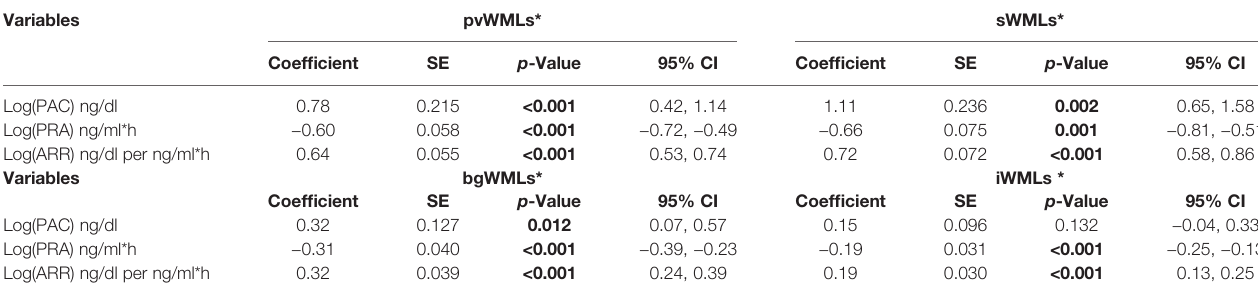
TABLE 4 | Correlation between PAC, PRA, ARR, and score of pvWMLs, sWMLs, bgWMLs, and iWMLs in linear regression analyses. Variables